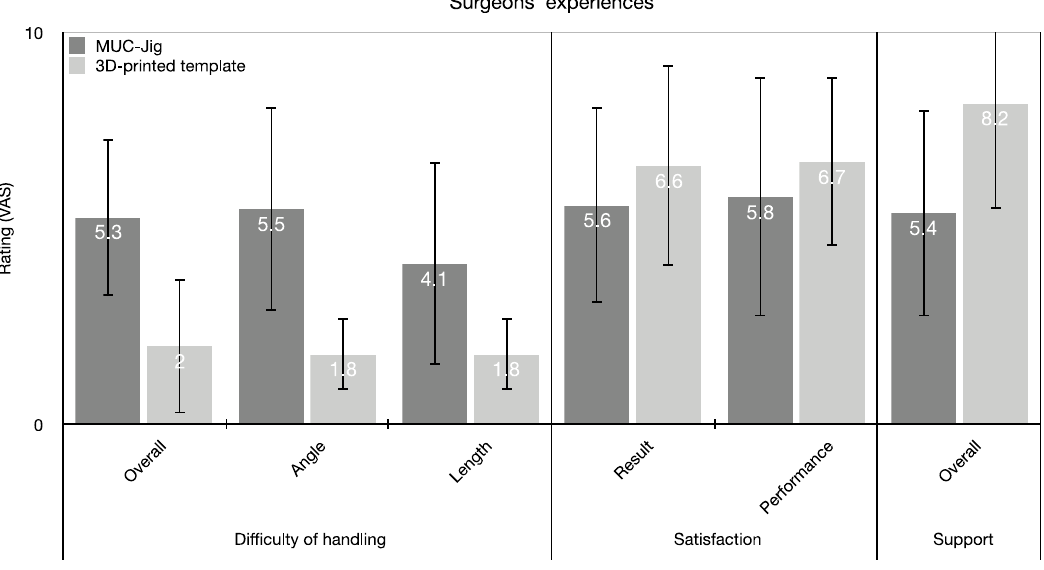
Figure 9. Mean values (± SD) of the surgeons’ subjective perception on a visual analogue scale (VAS). The surgeons were asked about the perceived difficulty of the methods in terms of general application, length, and angle conversion. Furthermore, the support perceived by the method and the satisfaction was also evaluated with regard to their performance and the result achieved.